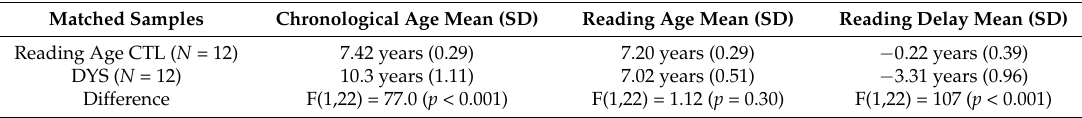
Table 2. Characteristics of subsamples of children with dyslexia (“DYS”) and control children of the same reading age (“Reading Age